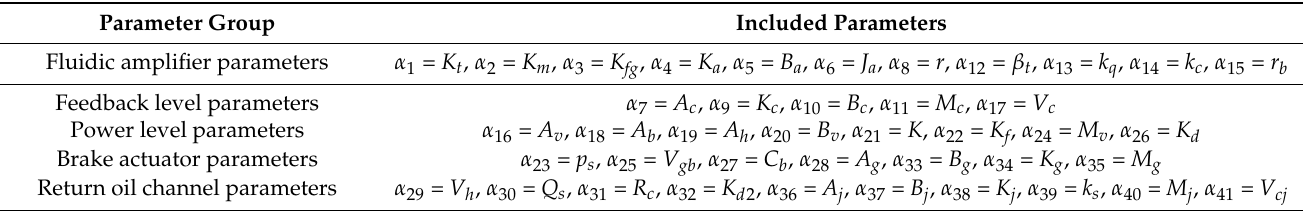
Table 3. Grouping of specific parameters.